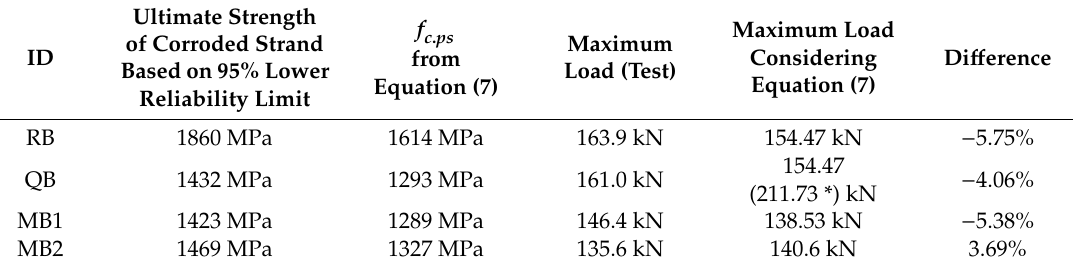
Figure 17. Determination of f c . ps from 95% lower reliability limit of ultimate strength. Table 4. Flexural strength evaluation using approximated determination of f ps with Equation